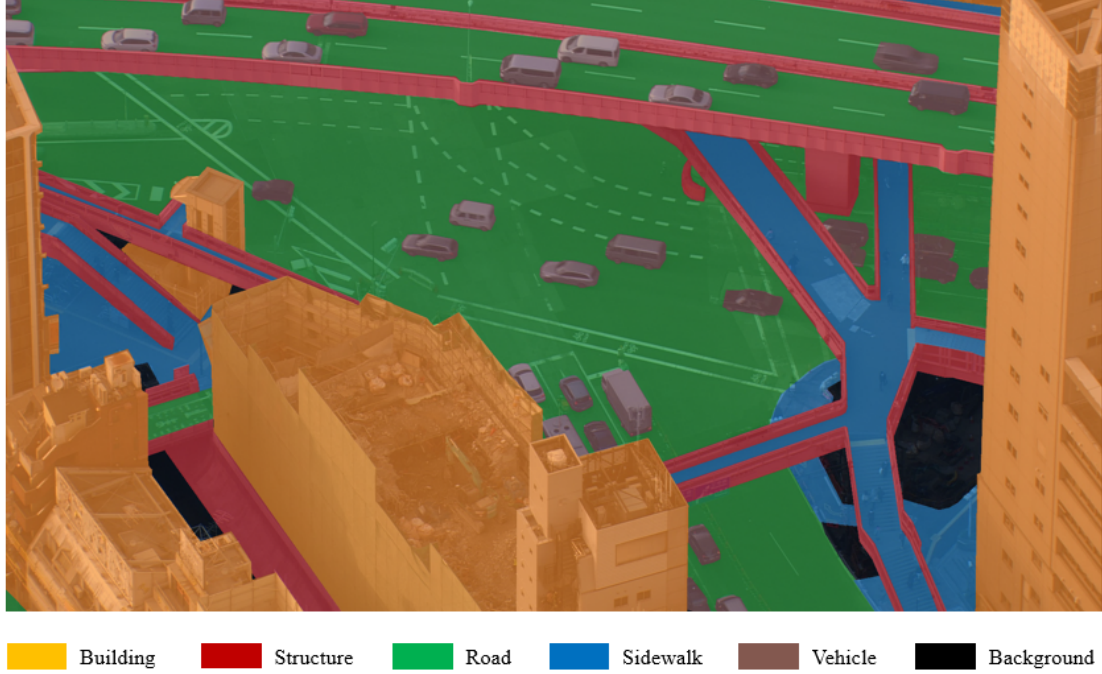
Figure 2. Semantic segmentation of background for helicopter footage, where humans are